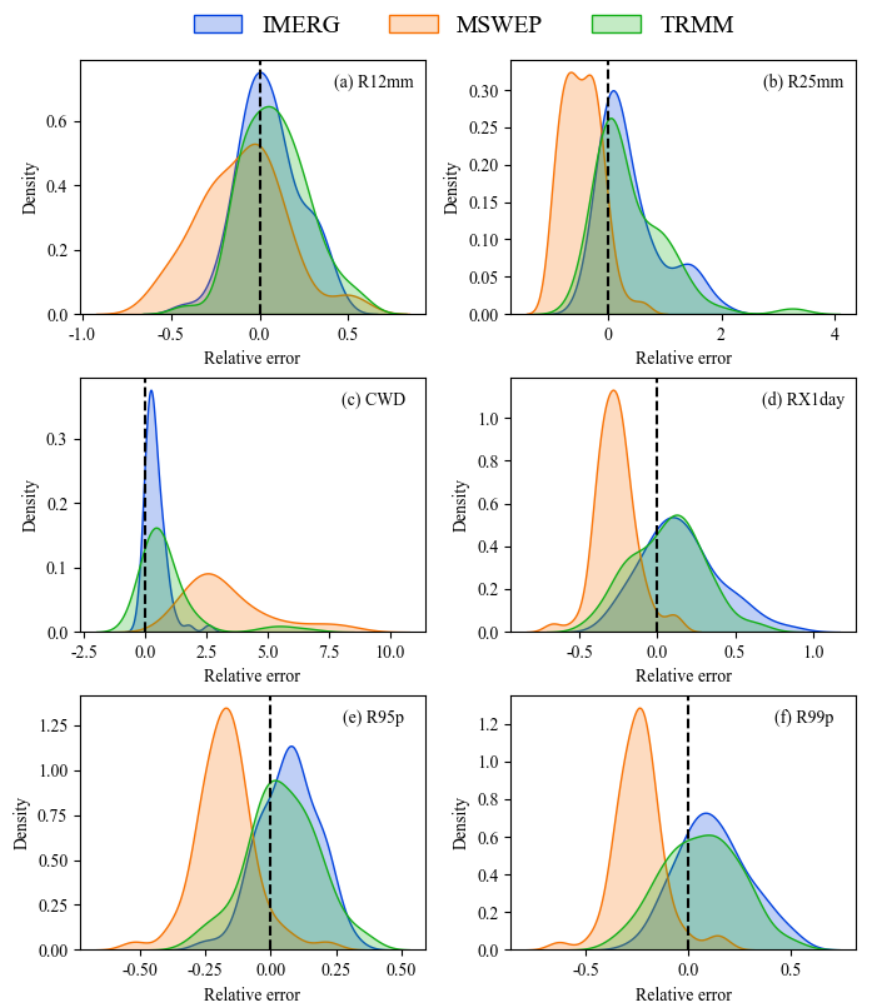
Figure 8. Extreme precipitation index: ( a ) R12mm, ( b ) R25mm, ( c ) CWD, ( d ) RX1day, ( e ) R95p, and ( f ) R99p kernel density estimate distribution curves for the three precipitation products.